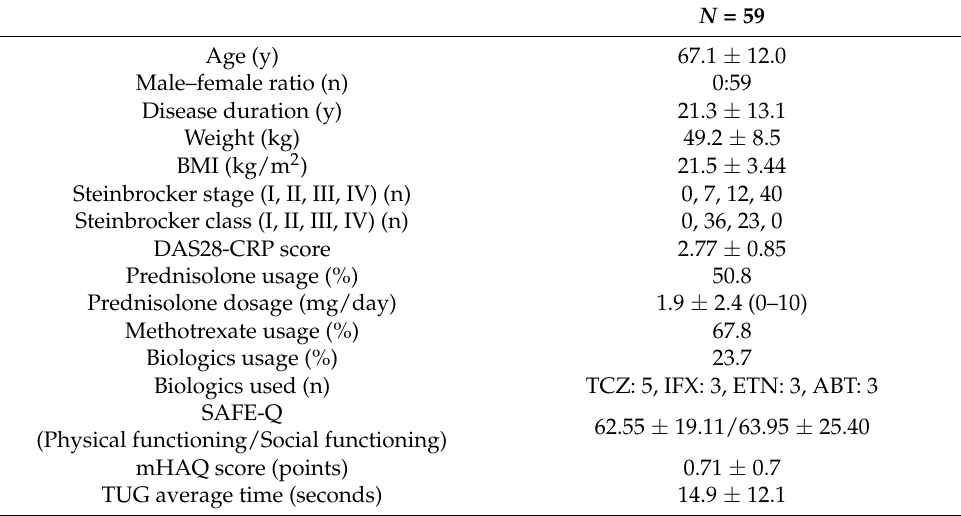
Table 1. Characteristics of patients with RA and ADL/physical mobility